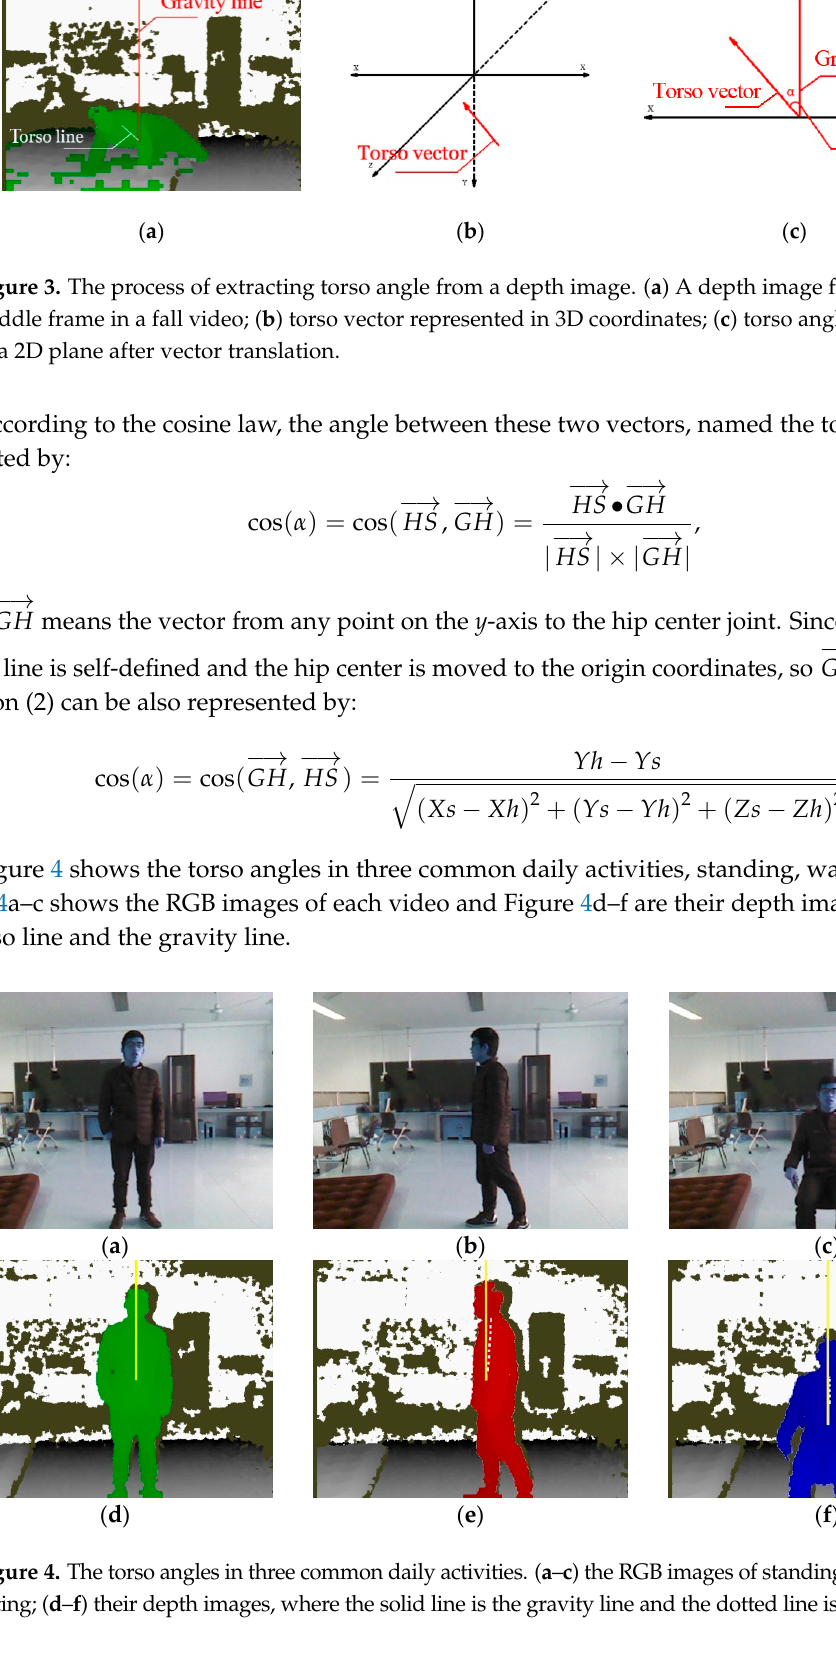
Figure 4. The torso angles in three common daily activities. ( a – c ) the RGB images of standing, walking and sitting; ( d – f ) their depth images, where the solid line is the gravity line and the dotted line is the torso line.